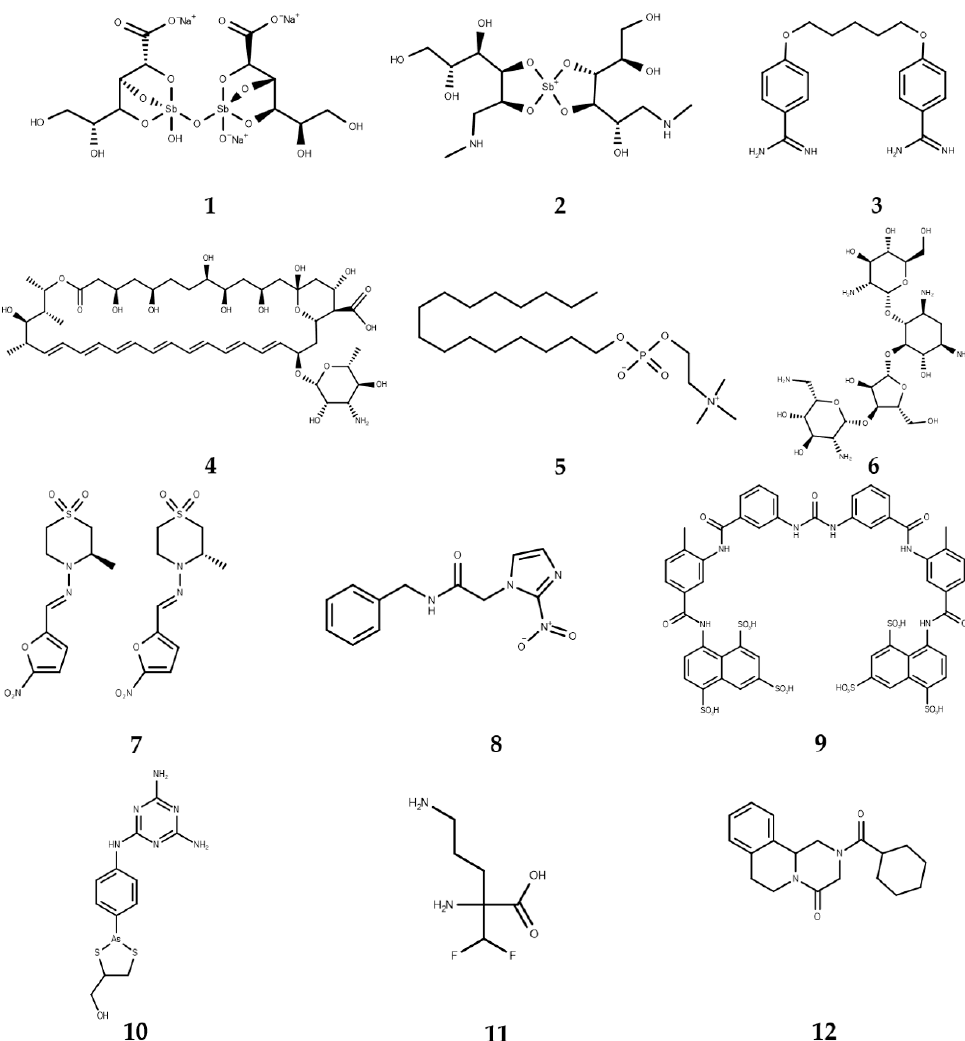
Figure 1. Chemotherapy used against four neglected tropical diseases.